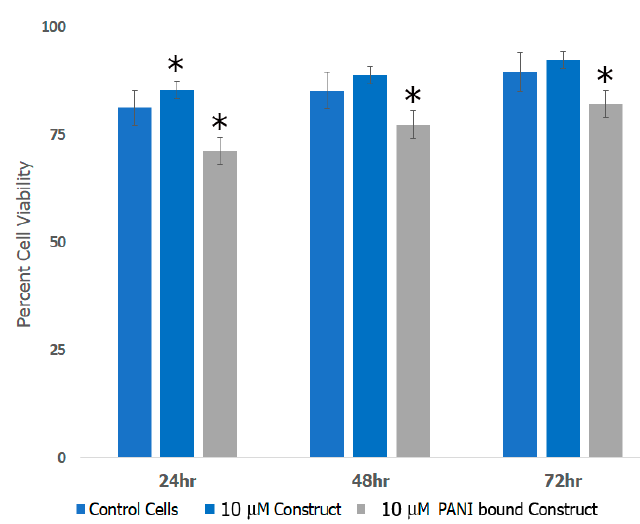
Figure 10. Cortical cell viability in the presence of scaffold constructs before and after incorporation of PANI. (* = p < 0.05 was determined to be statistically significant).